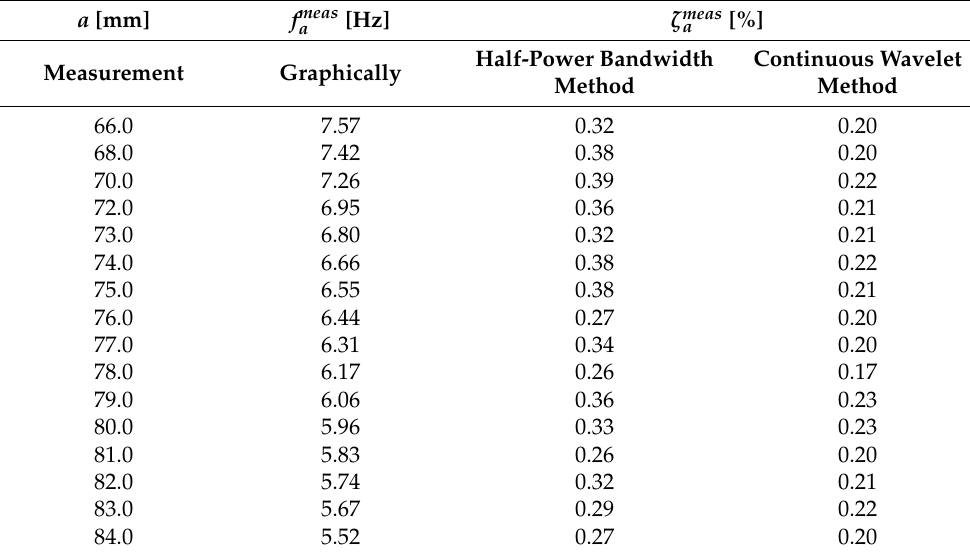
Table 1. Fundamental frequency of the TMD for each screw position and the corresponding modal damping ratio obtained using different